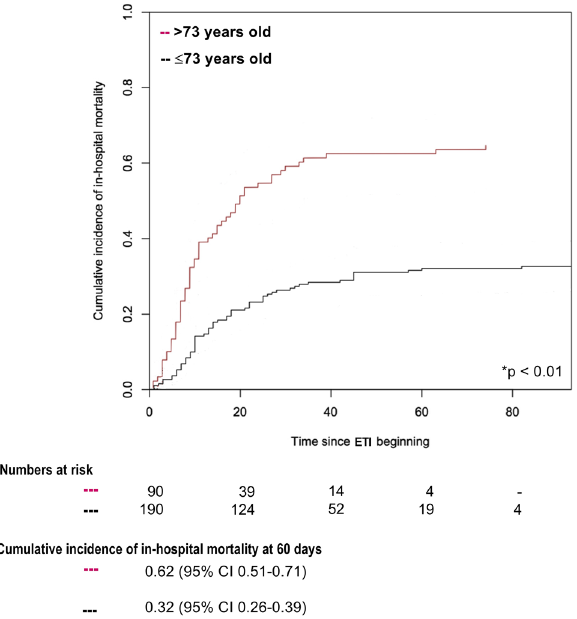
Figure 2. In-hospital mortality stratified by age (≤ or > 73 years). p Value Gray’s test was used for calculating equality of cumulative incidence function. The median age of non-survivors (= 73 years) was considered as the cut-off value for stratifying patients in two groups. NIV: non-invasive ventilation; ETI: endotracheal intubation.